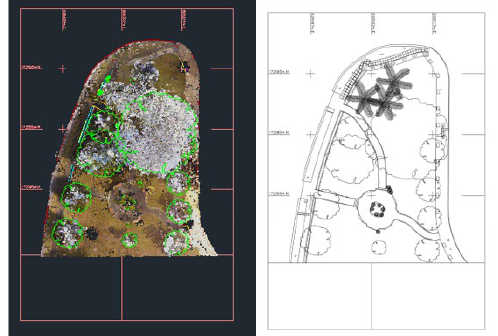
Figure 2.3 Side-by-side aerial view of 3D point cloud and digitized based map and been converted into a portable document